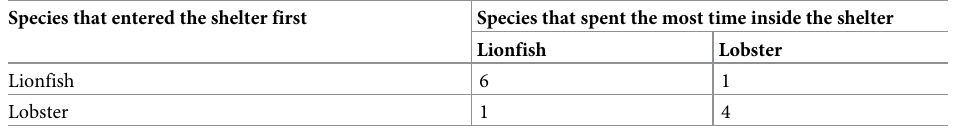
Table 2. Shelter occupancy data from lionfish-lobster together trials. Species that entered the shelter first Species that spent the most time inside the shelter Lionfish Lobster Lionfish 6 1 Lobster 1 4 Trials ( n = 12) are categorised based on which species entered the shelter first and which species spent the most time inside the